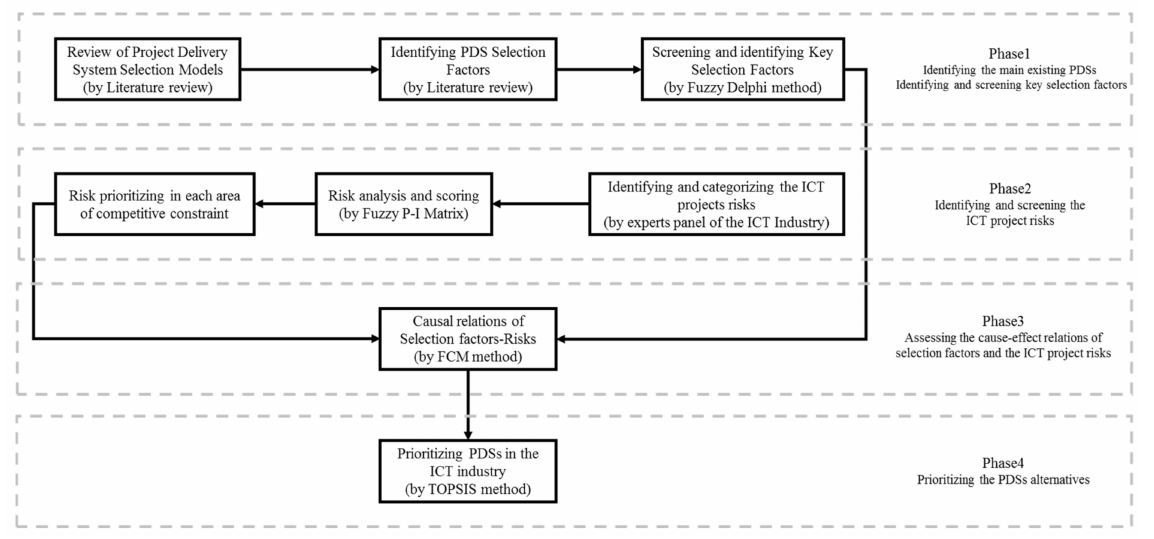
Figure 1. Research methodology.